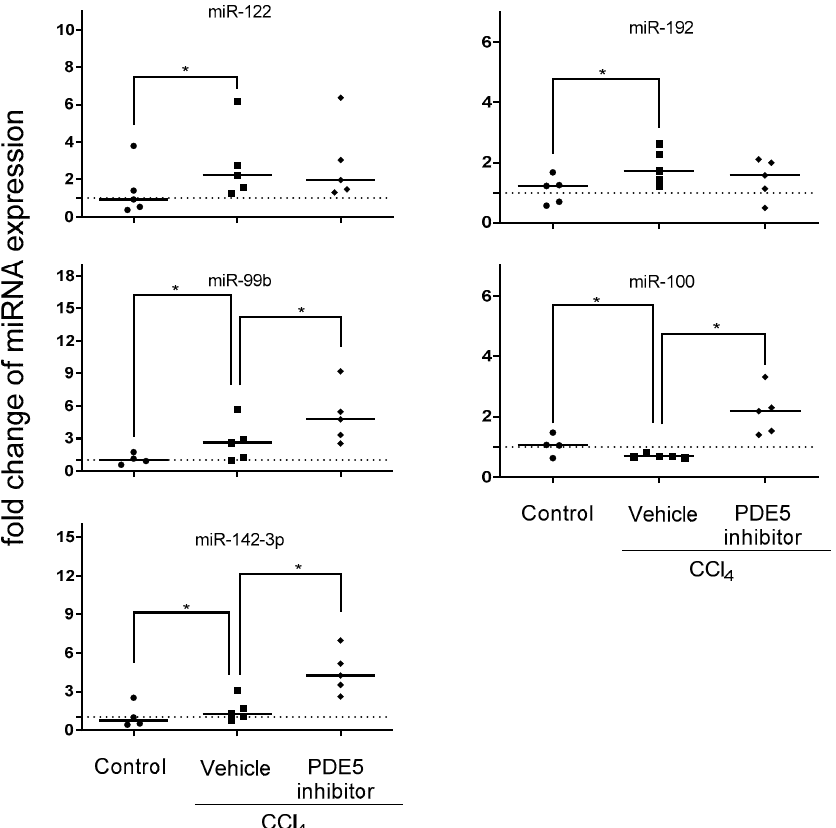
Figure 5. Plasma exosomal miRNA expression. Plasma exosomal levels of miR-99b, miR-100, miR-142-3p, miR-122, and miR-192 in control, CCl 4 /Vehicle and CCl 4 /PDE5 inhibitor treated rats. Relative plasma exosomal miRNA expression analyzed by qRT-PCR was normalized to the mean expression of control rats. The median is depicted and significant differences between experimental groups are indicated by * ( p < 0.05).